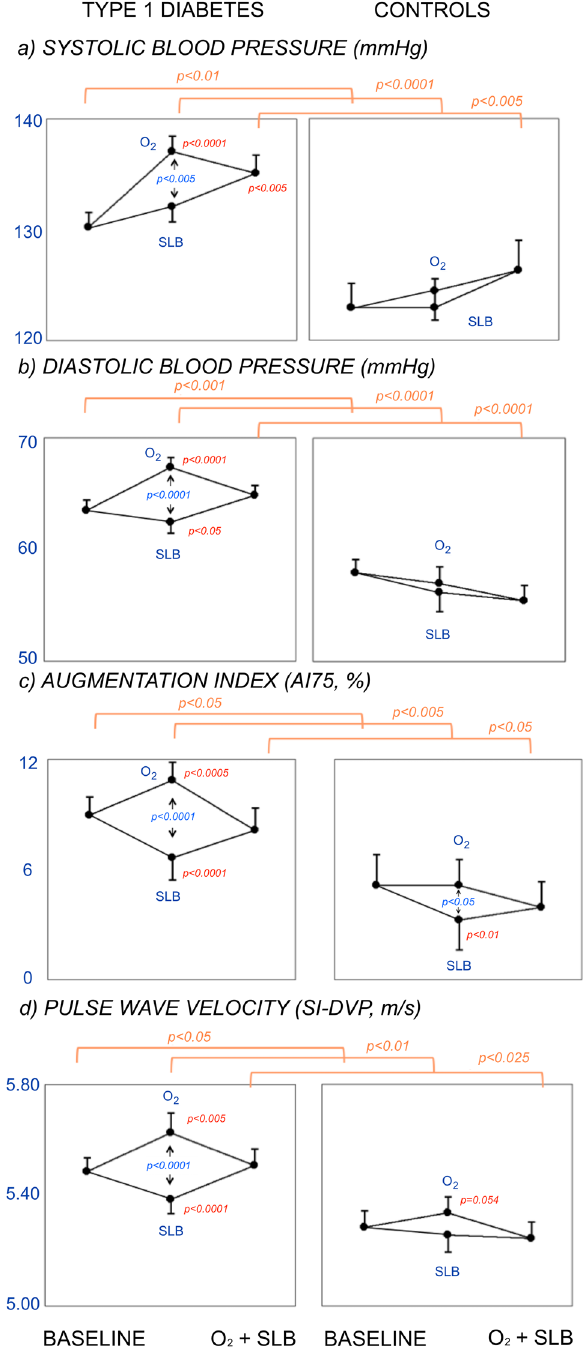
Figure 2. Effect of Slow Breathing (SLB) and Oxygen (O 2 ), alone (middle data of each panel) and combined (right data in each panel) on blood pressures: systolic (panels a) and diastolic (panels b), and arterial function: heart rate-adjusted augmentation index (AI75, panels c) and Pulse wave velocity (SI-DVP, panels d). Same explanations as in Fig. 1. Note the opposite effects of slow breathing and oxygen on blood pressure and particularly on each index of arterial function, and the blockade of the oxygen-induced worsening by combining slow